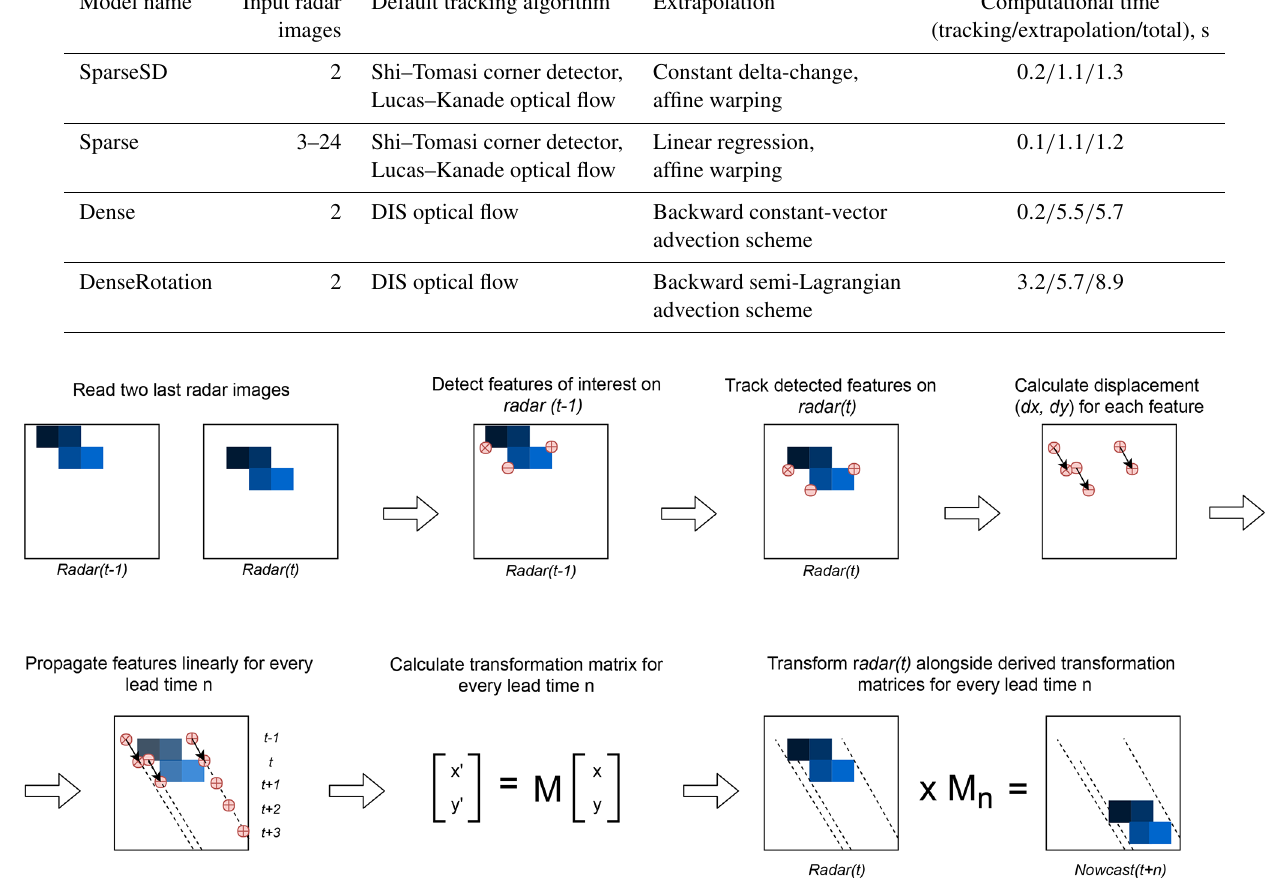
Figure 1. Scheme of the SparseSD